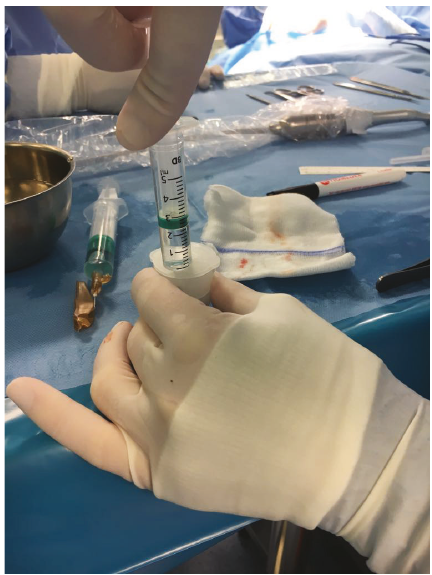
Figure 8: Imbibition of the dermal substitute with the saline micrograft